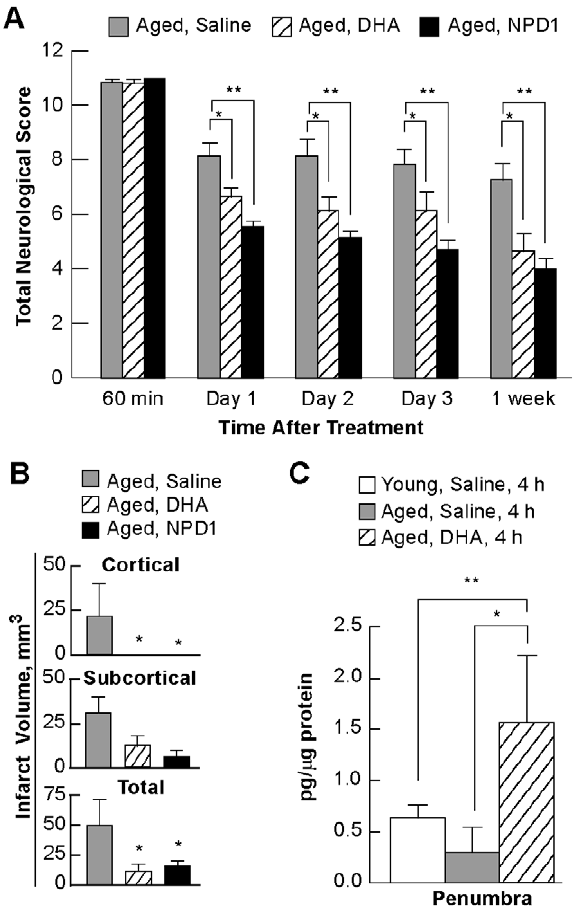
Figure 5. Behavioral, histopathology and lipidomic analysis in aged rats. Panel A: Behavioral outcomes over 7 days. Panel B: Total, cortical and subcortical infarct volumes on day 7 after stroke. Panel C: NPD1 content was analyzed by lipidomic analysis at 4 h in young and aged rats treated with either saline or DHA. Data are mean 6 SEM. * and ** indicate significant difference between groups (p , 0.05; repeated measures ANOVA followed by Bonferroni tests).